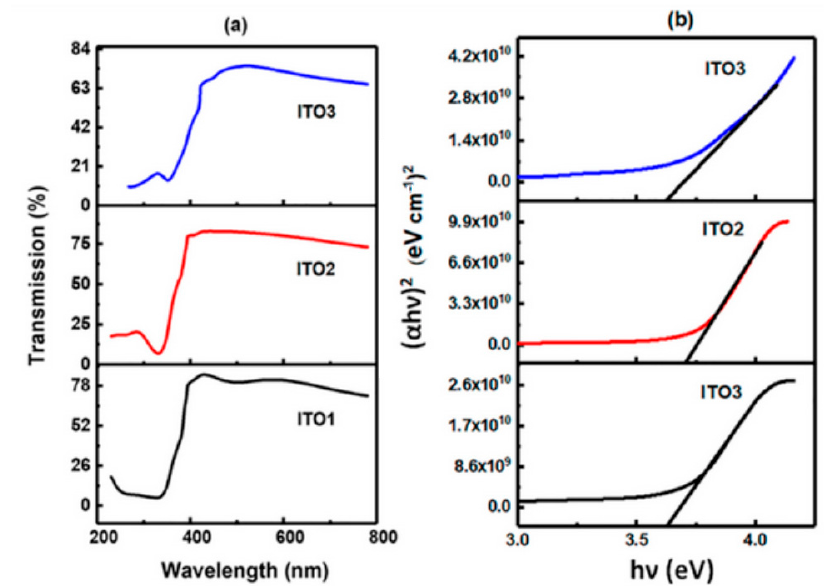
Figure 7. ( a ) Transmission curves of ITO films, ( b ) Tauc plots to determine the band gap. Reproduced with permission from Ref. [15]; published by IOP Publishing,